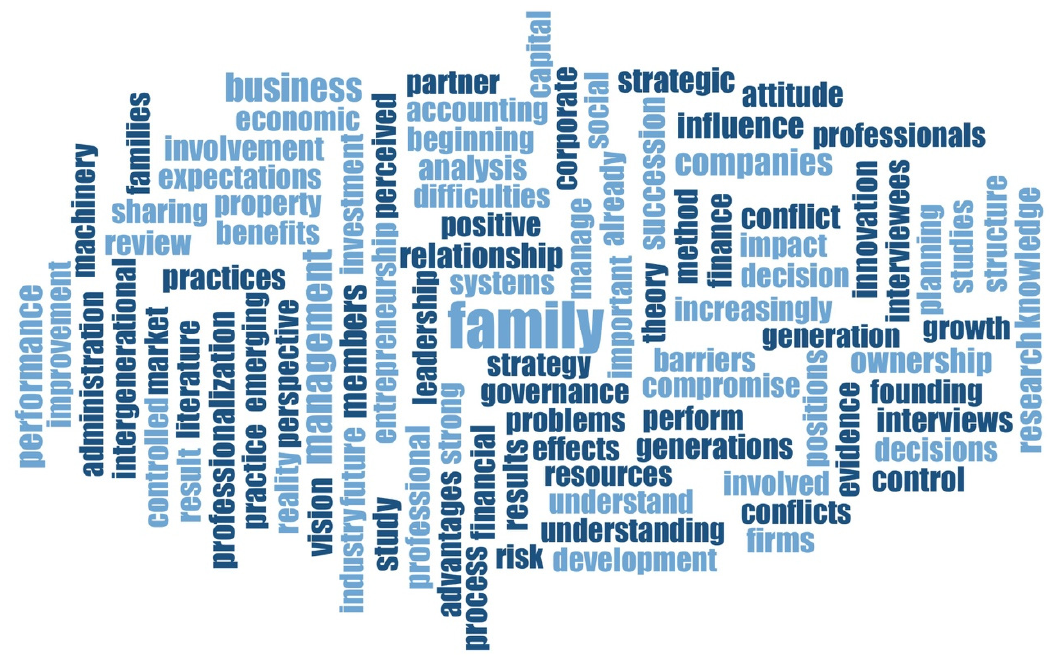
Figure 5. Word Cloud. Source: elaborated by the authors.